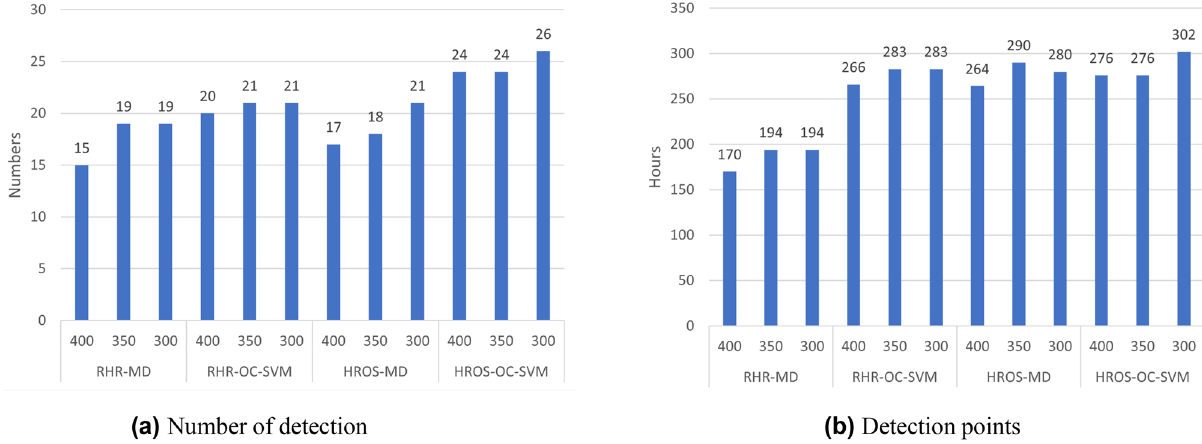
Figure 2. Variations of anomaly detection performances by moving